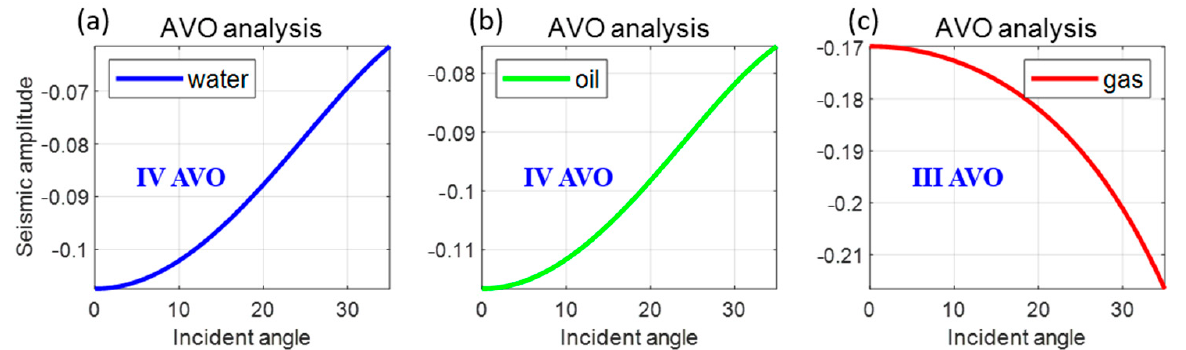
Figure 12. AVO types of different fluids in the logging curves of low-velocity sandstone: ( a ) water, ( b ) oil, and ( c ) gas.